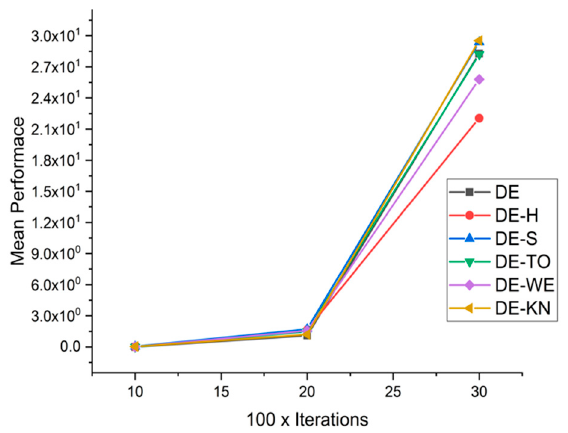
Figure 38. Convergence curve on fn16.